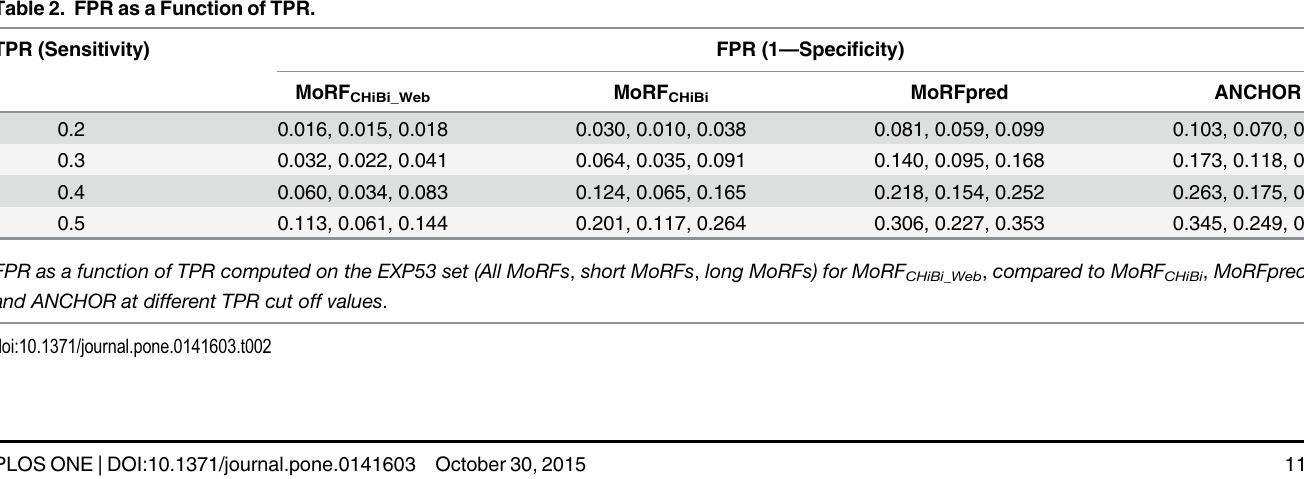
Table 2. FPR as a Function of TPR.